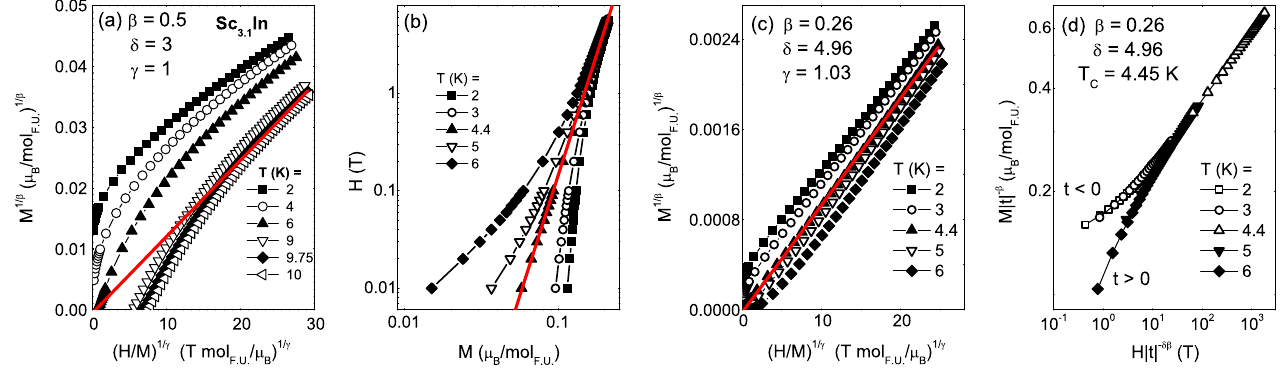
¼ 0 . 5 and γ ¼ γ ¼ 1 , T ¼ 9 . 75 K (solid line) In with (a) MF exponents β ¼ β C . 1 MF MF ¼ 4 . 45 K (solid line). (b) Log-log plot of Sc 3 . 1 In M(H) isotherms, with the C ( t < 0 , open symbols) and one above T ( t > 0 , full symbols). C C